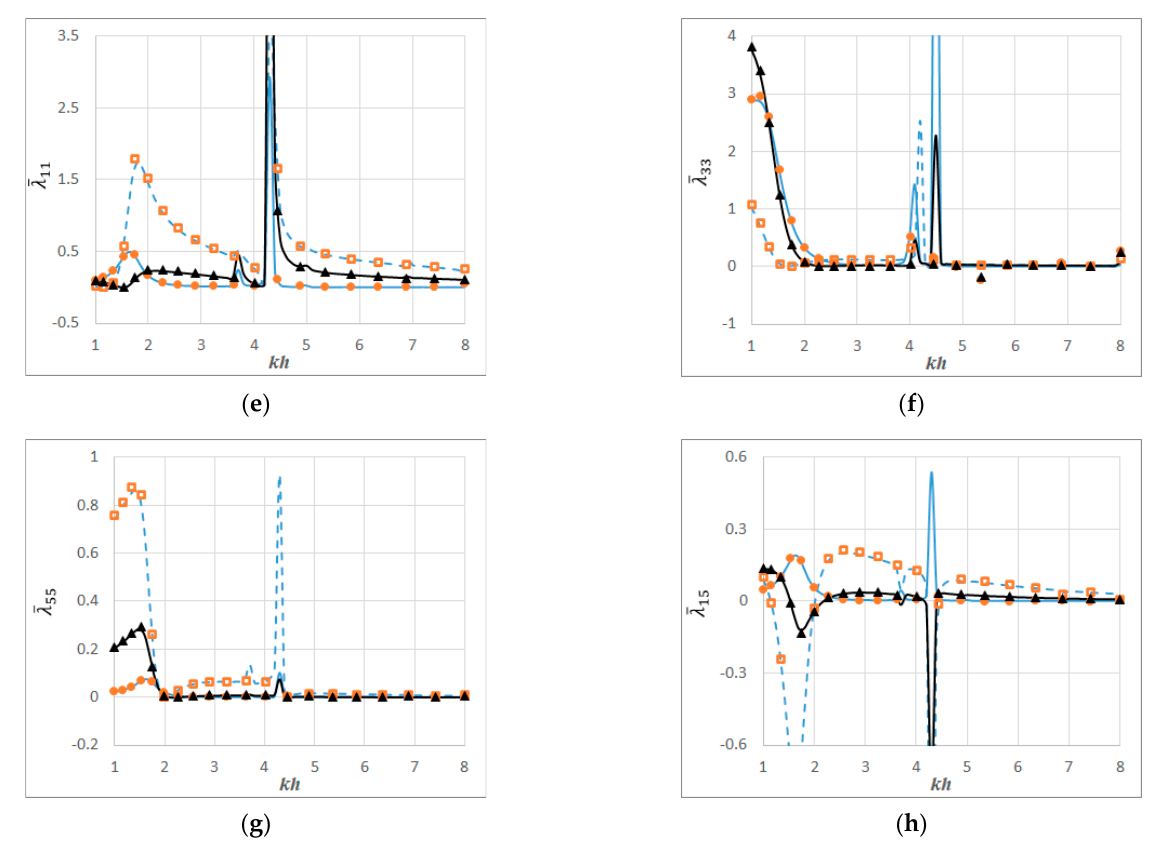
Figure 4. Comparison of normalised added mass and radiation damping obtained from AQWA and present approach: ( a ) added mass for surge; ( b ) added mass for heave; ( c ) added mass for pitch; ( d ) added mass for surge ‐ pitch; ( e ) radiation damping for surge; ( f ) radiation damping for heave; ( g ) radiation damping for pitch; ( h ) radiation damping for surge ‐ pitch.